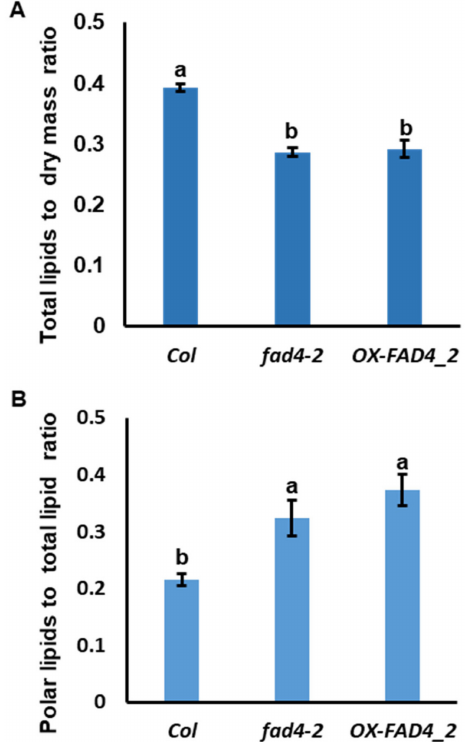
Figure 4. Disruption of FAD4 expression altered the ratio of total lipids to dry plant mass and the ratio of polar lipids to total lipids. ( A ). Total lipids to dry plant mass ratios of Col , fad4-2 , and OX-FAD4_2 plants; ( B ). The polar lipids to total lipid ratios of Col , fad4-2 , and OX-FAD4_2 plants. The difference letter represent statistically